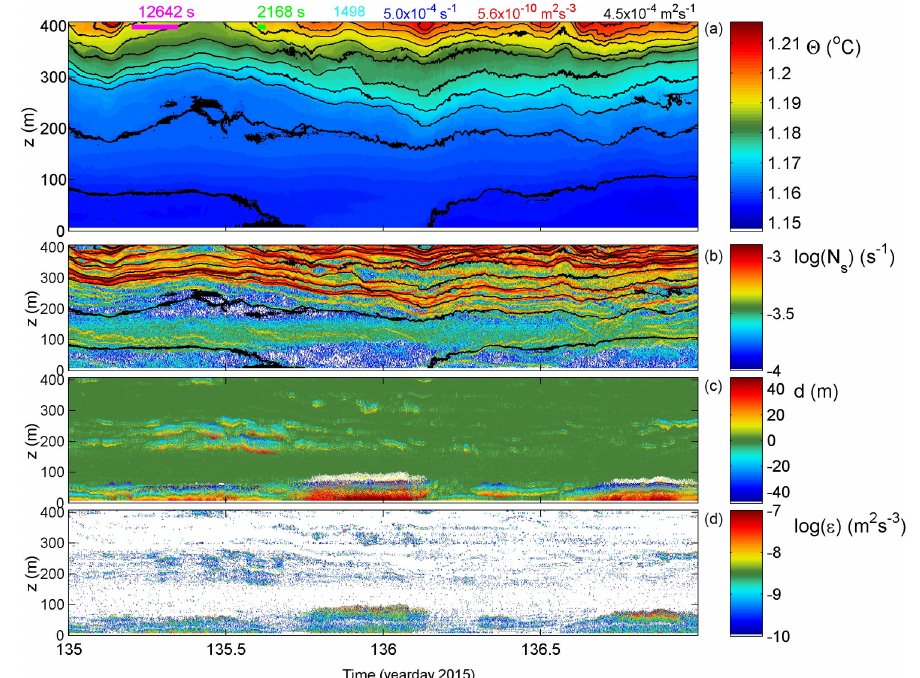
Figure 9. As Fig. 3 with identical colour ranges, but for a 2-day period with some intense convective turbulence also near the